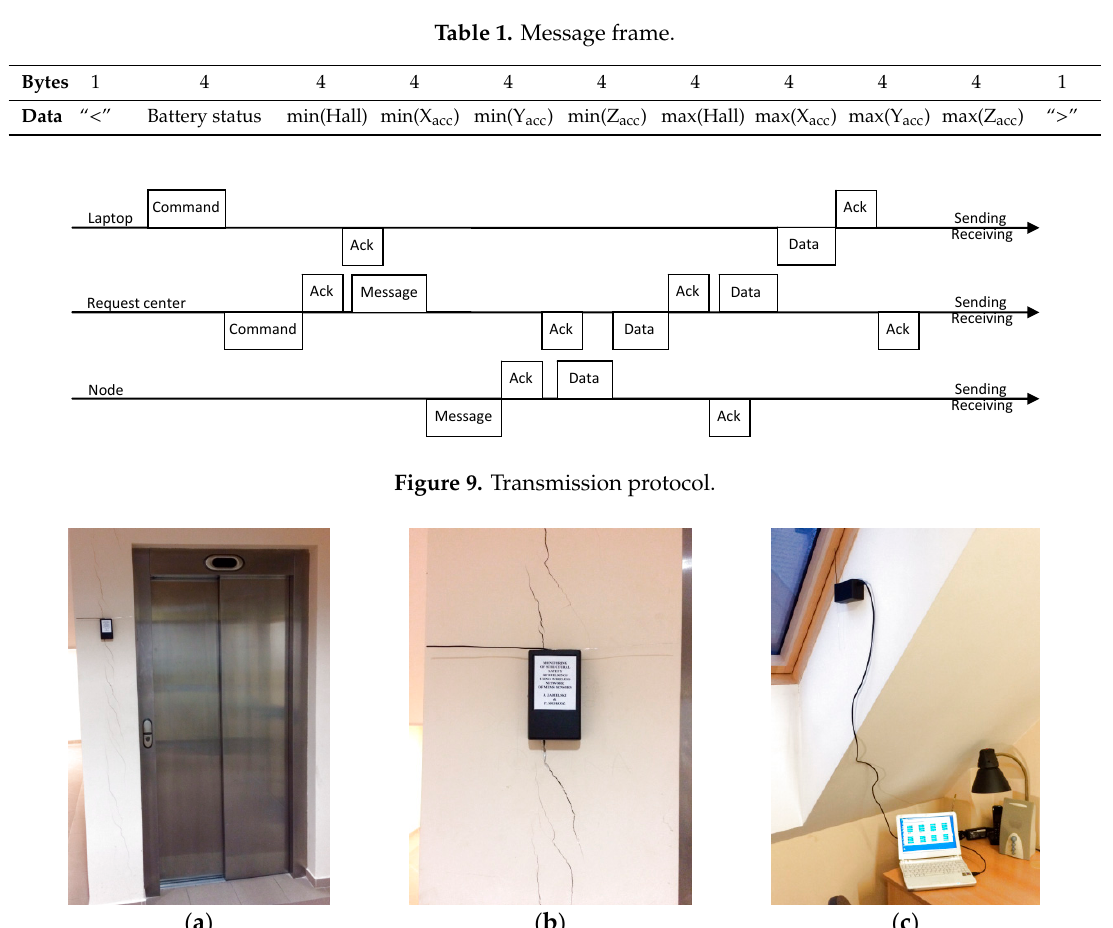
Figure 10. Modules view: ( a ), ( b ) Node located at the elevator shaft; ( c ) Request center.